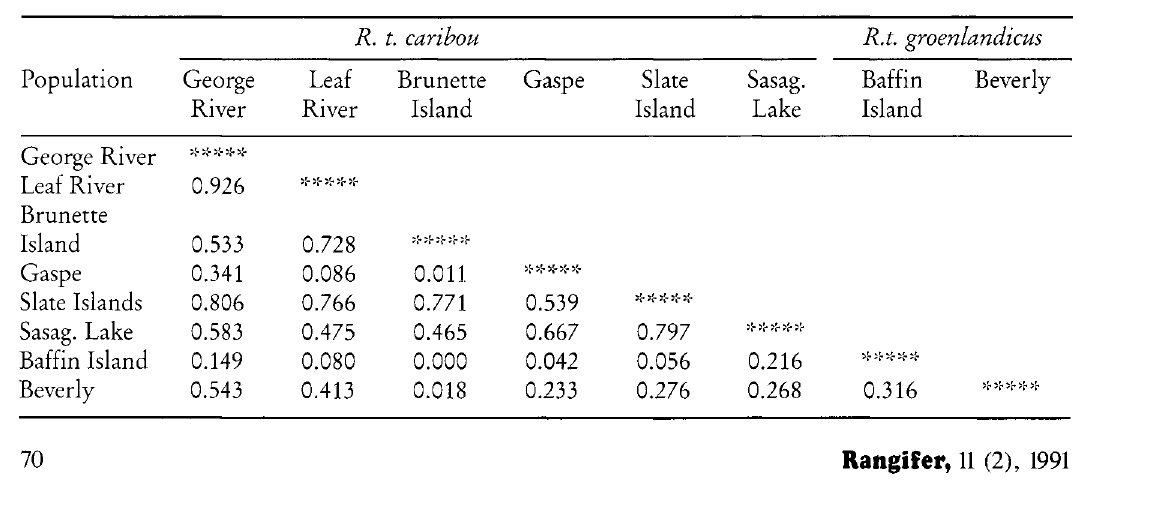
Table 2. Genetic identities (Nei, 1972) between different Canadian populations of